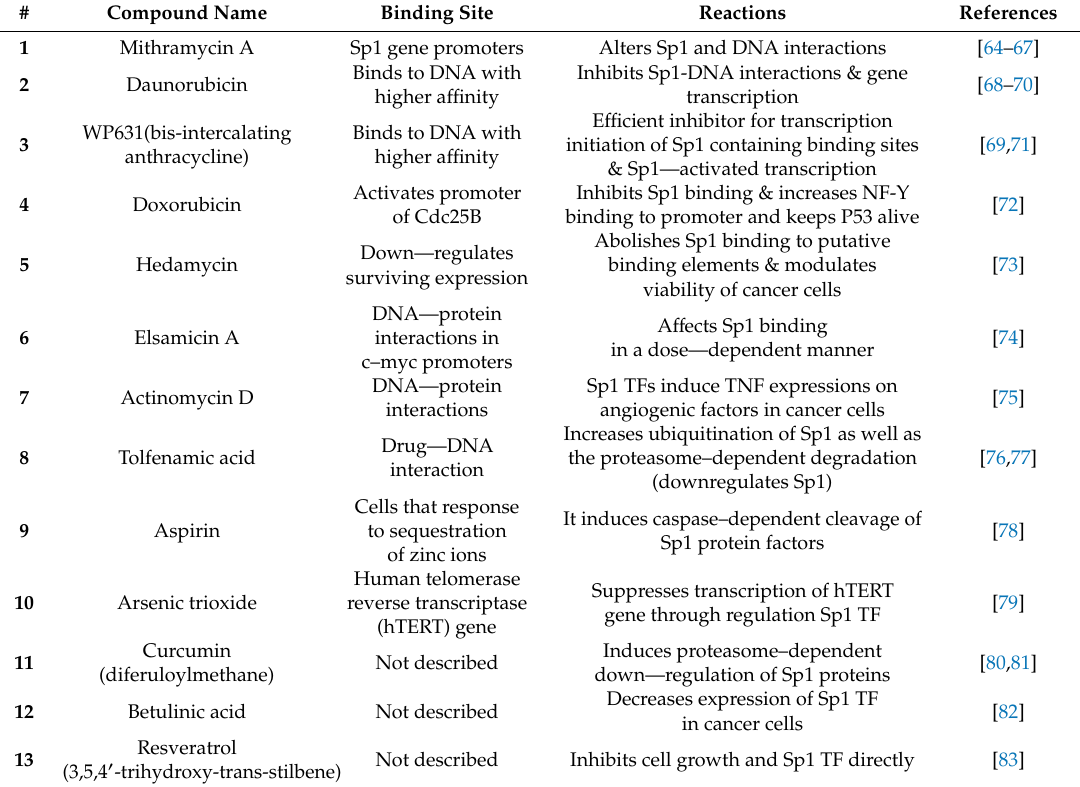
Table 1. Sp1-targeting Drug